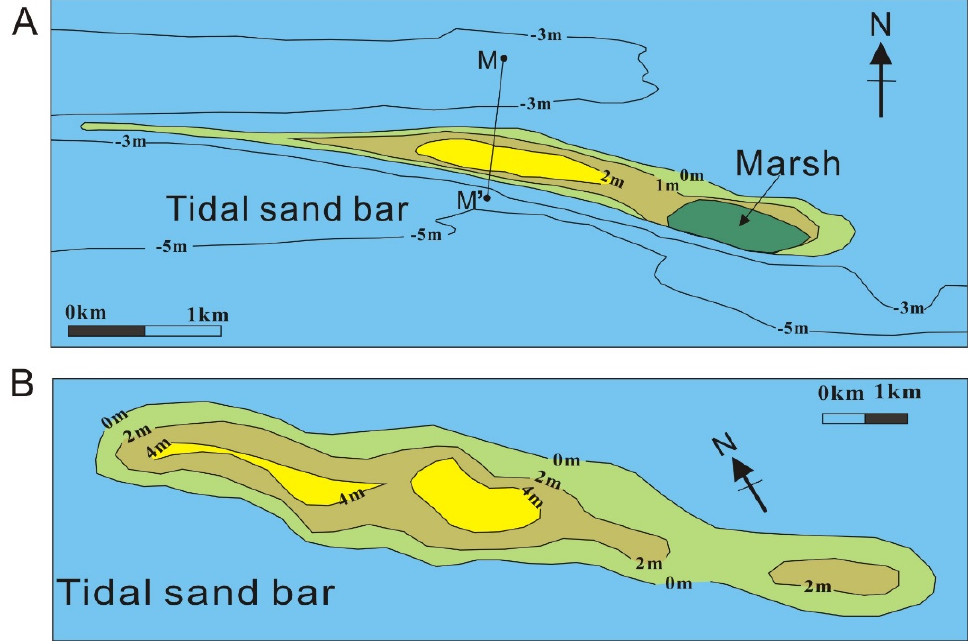
Figure 10. Spatial distribution of elongated tidal bars in McMurray Formation and Gironde Estuary: ( A ) Bathymetry of elongated tidal bar in Gironde Estuary, France (modified from Fenies and Tastet, 1998); ( B ) Isopach map of sand bar complex unit 3, McMurray